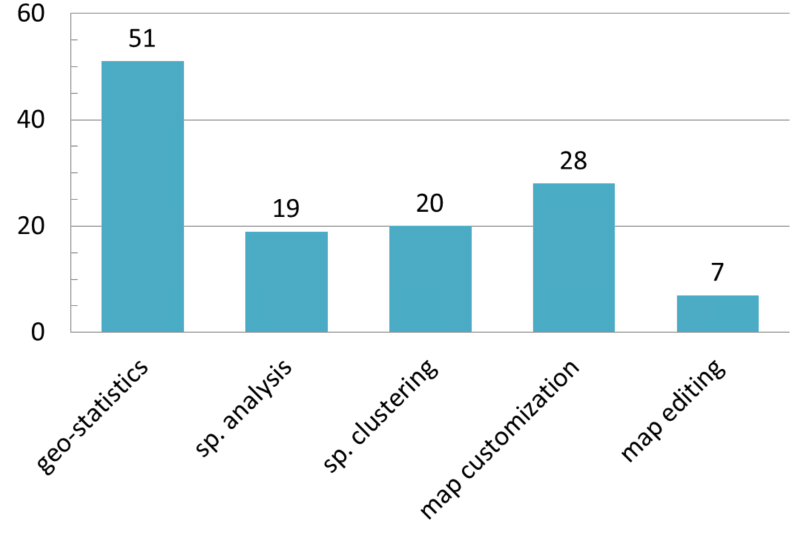
Figure 12. Summary of the results relative to the approaches for operations on